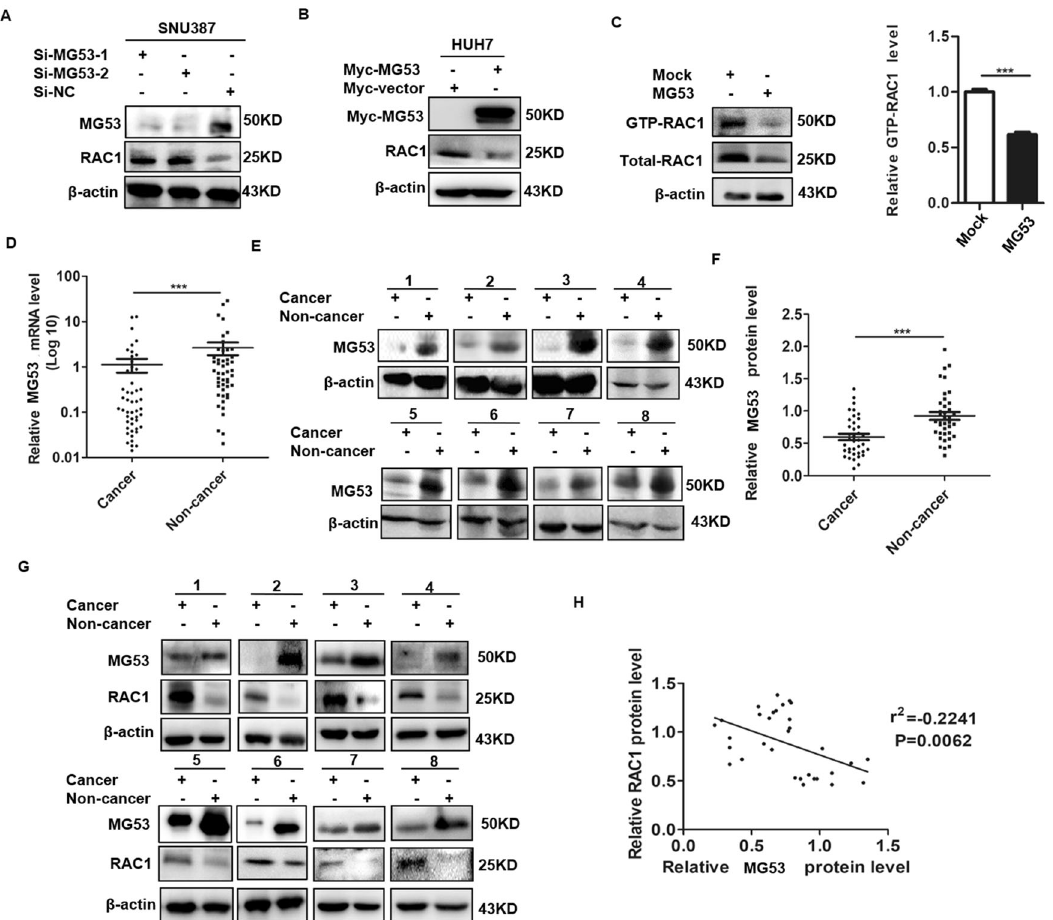
Fig. 2 RAC1 expression was downregulated by MG53 in HCC cells and clinical HCC specimens. A SNU387 cells were transfected with Si- MG53 or Si-NC and further cultured for 48 h before western blot assay was performed to detect the expression level of RAC1. B HUH7 cells were transfected with Myc-MG53, and Myc-vector transfected cells acted as a mock control. 24 h after the transfection, western blot assay was performed to detect the expression level of RAC1. C HUH7 cells were transfected with Myc-MG53 or mock control. 24 h after the transfection, the relative levels of GTP-RAC1 and total RAC1 were detected by RAC1 GTPase activity kit. The expression of GTP-RAC1 after overexpression of MG53 were normalized with total RAC1. D Expression levels of MG53 mRNA in 51 pairs of HCC tissues and matched non-cancerous liver tissues were detected and statistically analyzed. E , F Western blot was performed to detect the relative protein levels of MG53 in paired HCC specimens and representative bands were presented ( E ). The relative band densities from all of the detected patients were analyzed by Image J software and normalized by β -actin ( F ). G , H Expression of MG53 and RAC1 in human hepatocellular carcinoma tissues from 30 HCC patients were detected by western blot ( G ). Correlation between the expression of MG53 and RAC1 was further analyzed ( H ). * P < 0.05, ** P < 0.01 and *** P < 0.001 for statistical analysis of the indicated